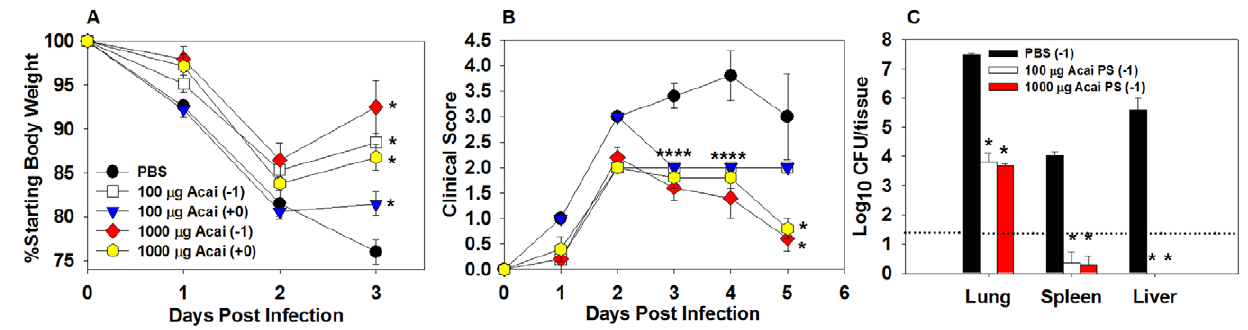
Figure 6. Nasal administration of Acai PS confers protection against pulmonary B.pseudomallei infection. Female C57BL/6 mice (n=5/ group) were treated i.n. with PBS or with 100–1000 m g of Acai PS one day prior to, or immediately after, intranasal infection with 3 6 10 3 CFUs of B. pseudomallei 1026b. A) Body weights and B) clinical scores were recorded daily, and C) on day 3, CFU determinations were performed in the lungs, spleens, and livers. Error bars depict SEM. *P , 0.05 as compared to PBS group. **** indicates that *P , 0.05 for all Acai PS-treated groups in relation to PBS-treated group at this time point. Data depicted in A–B) are representative of two independent experiments. The dashed line in C) indicates the limit of bacterial CFU detection.